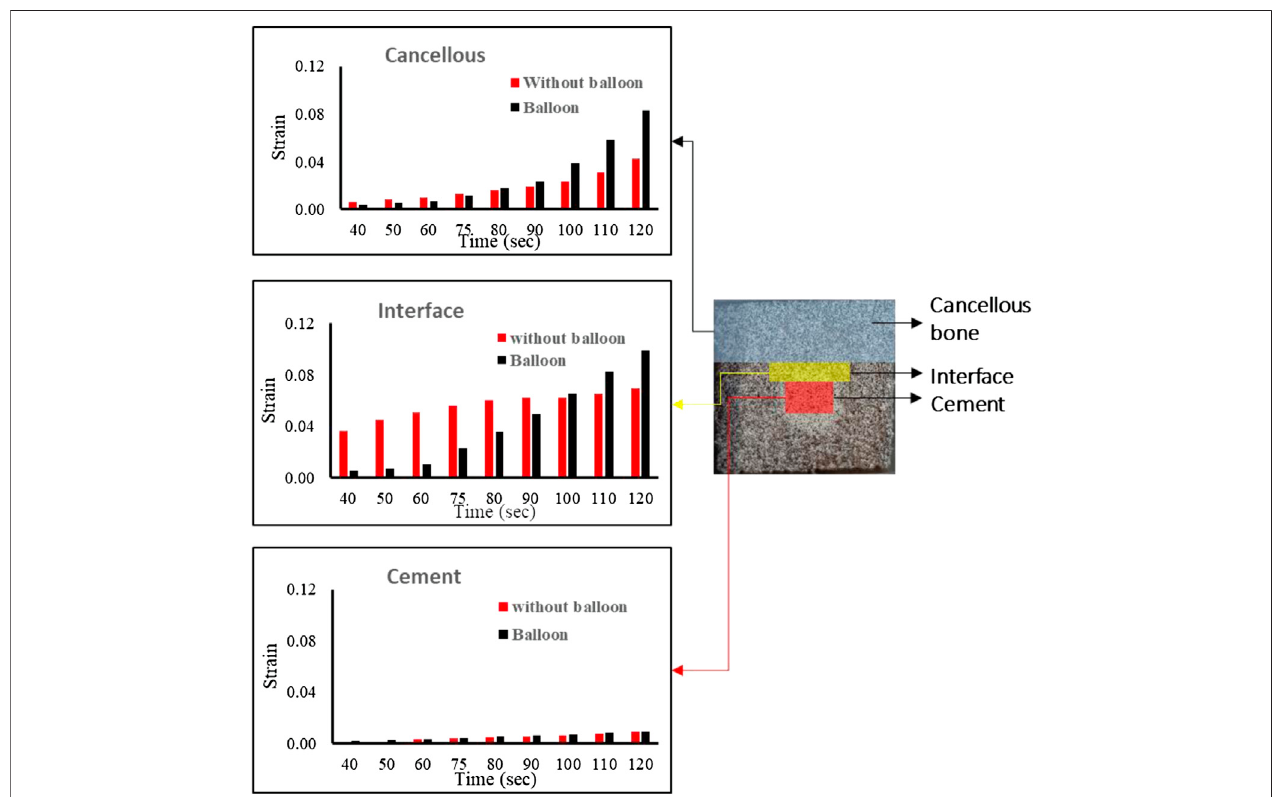
FIGURE 6 | Strain variation in different zones for a sample without the balloon and with the